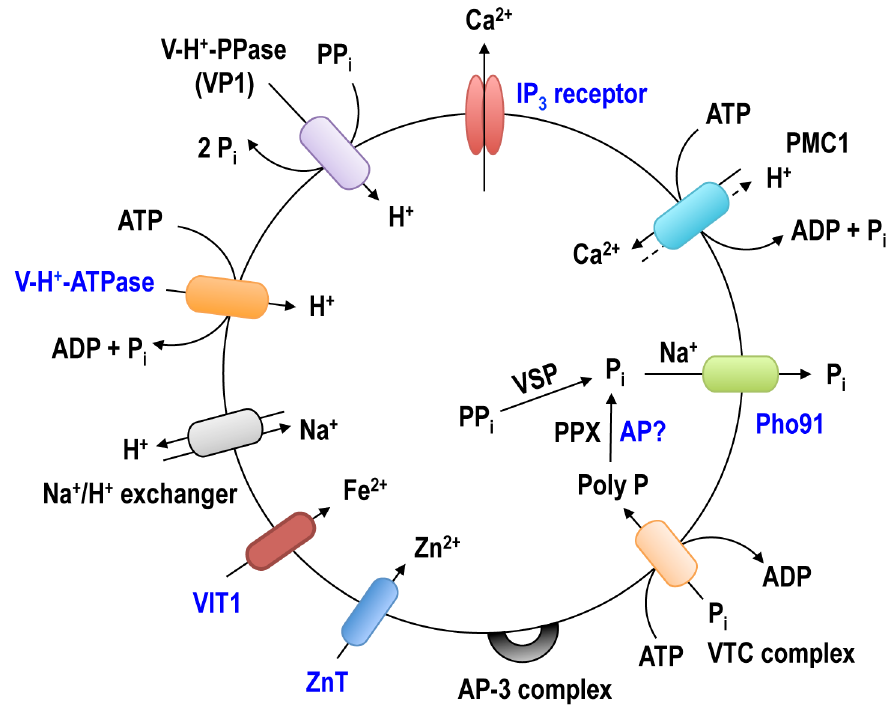
Fig. 7. Schematic representation of the acidocalcisome of T.brucei . The identified acidocalcisome proteins corresponding to the pumps, exchangers, transporters or protein complexes in Table 2 are shown in this model. The newly identified acidocalcisome proteins in this study are marked in blue.